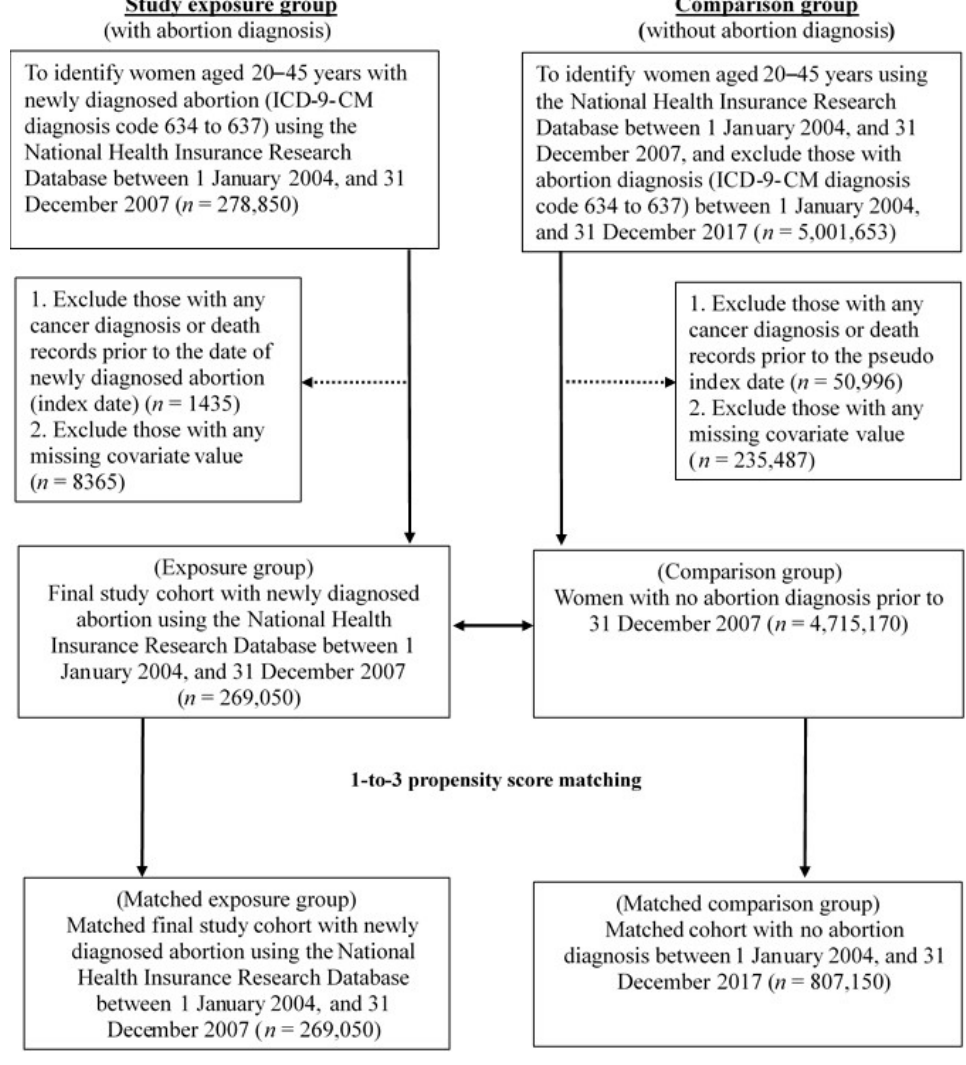
Figure 1. Flow chart of inclusion and exclusion criteria of the study population.